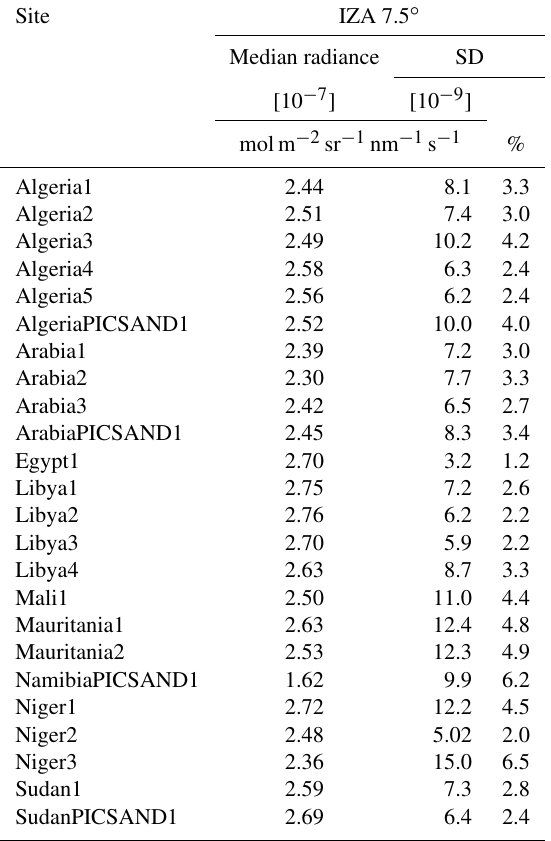
Table 4. Median radiance and standard deviation (both absolute and relative) for the sample with a instrument zenith angle (IZA) filter of 7.5 ◦ .